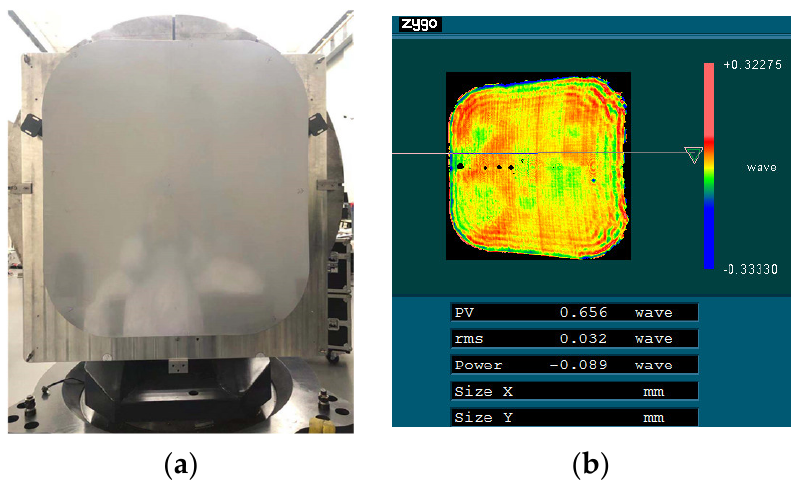
Figure 13. Test of mirror accuracy . ( a ) The mirror assembly is in the detection state. ( b ) Optical testing result of mirror a s sembly.